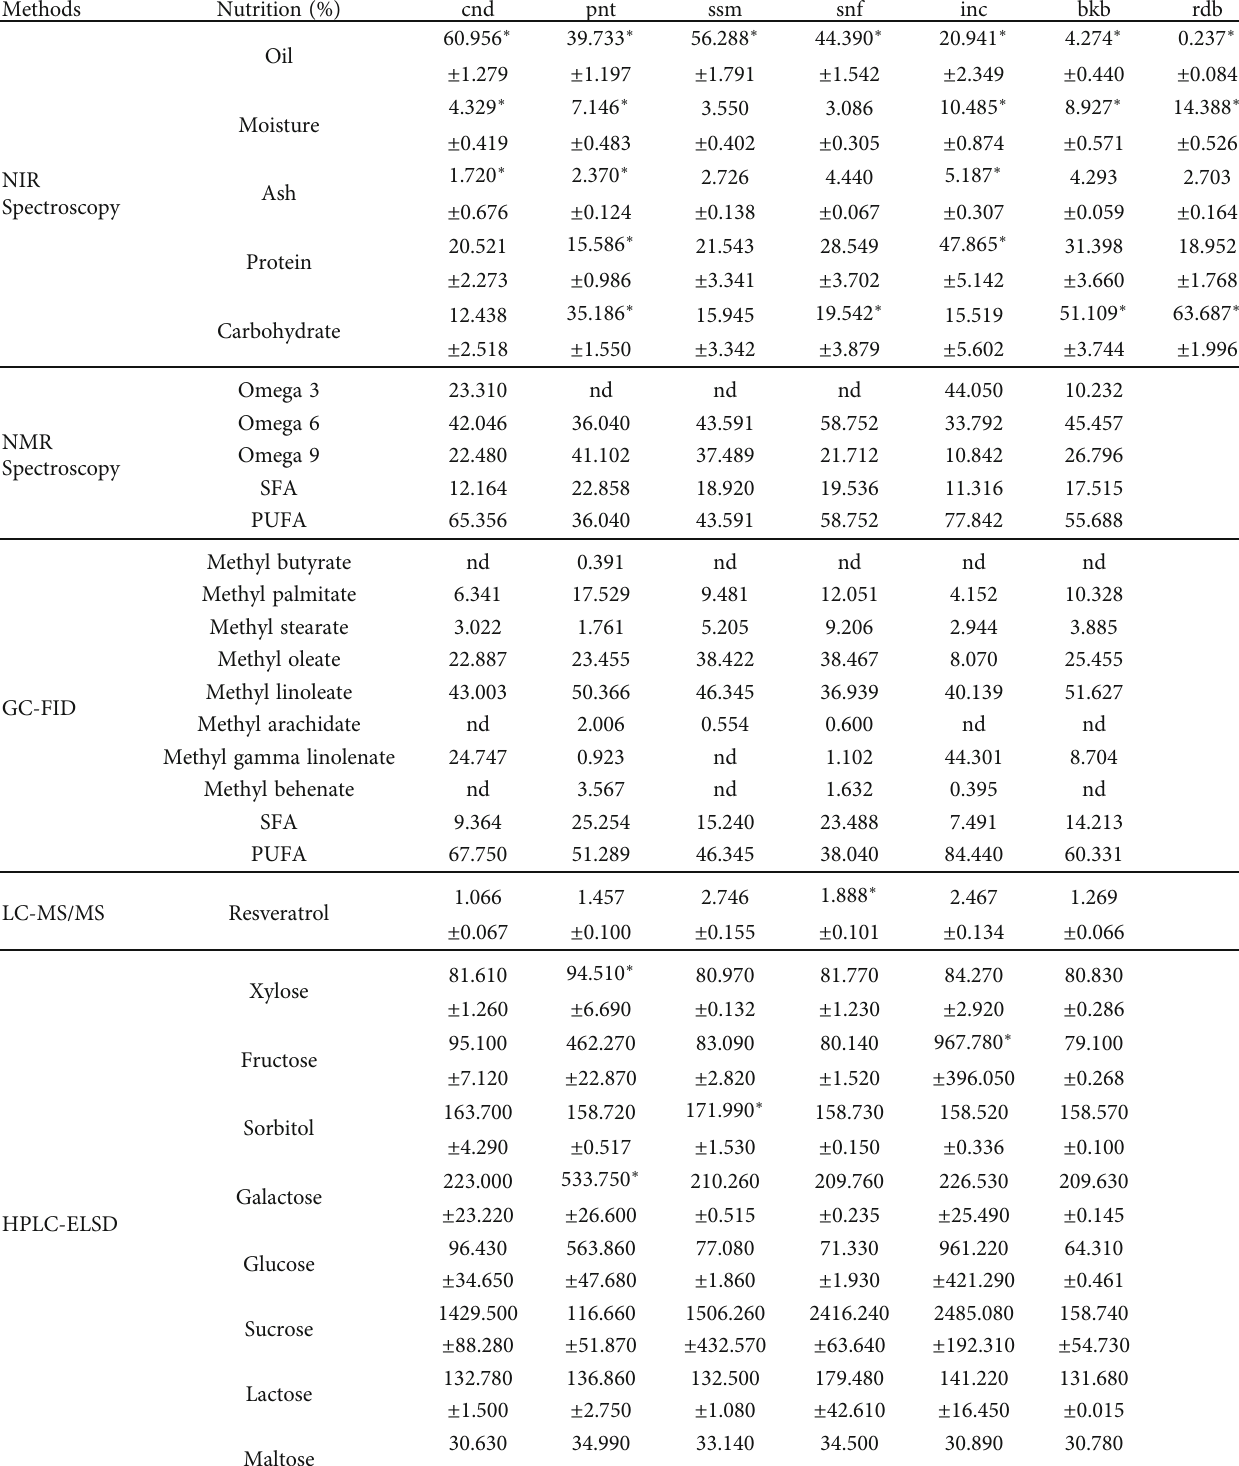
Table 2: The nutrition of candlenut (cnd), peanut (pnt), sesame (ssm), sun fl ower (snf), sacha inchi residue (inc), and black bean (bkb). Methods